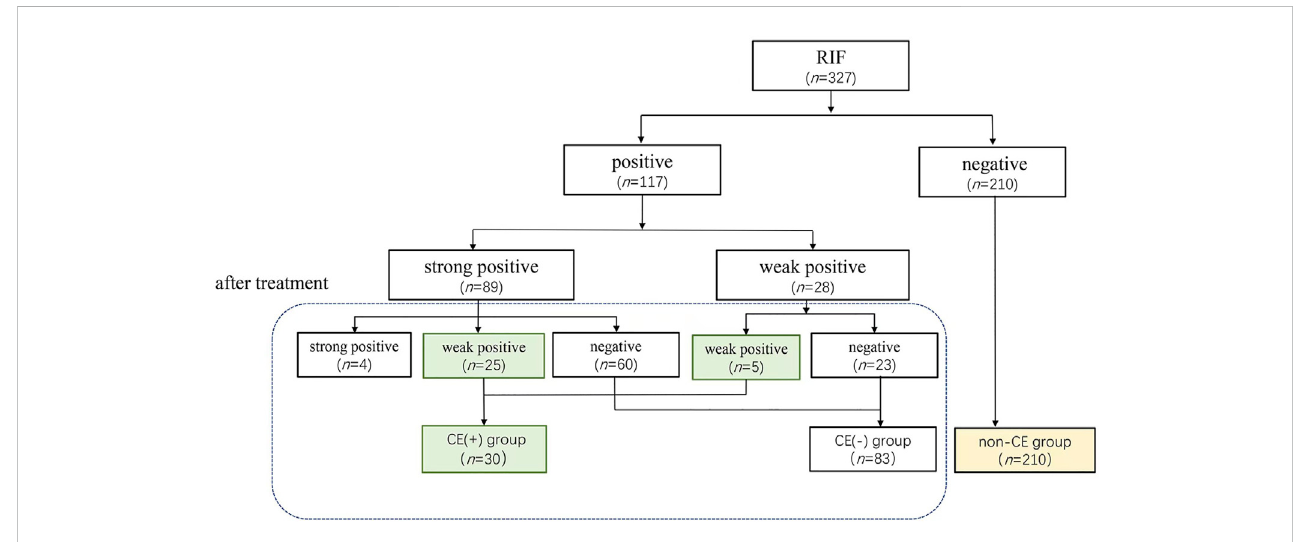
The clinical treatment procedure of RIF/CE